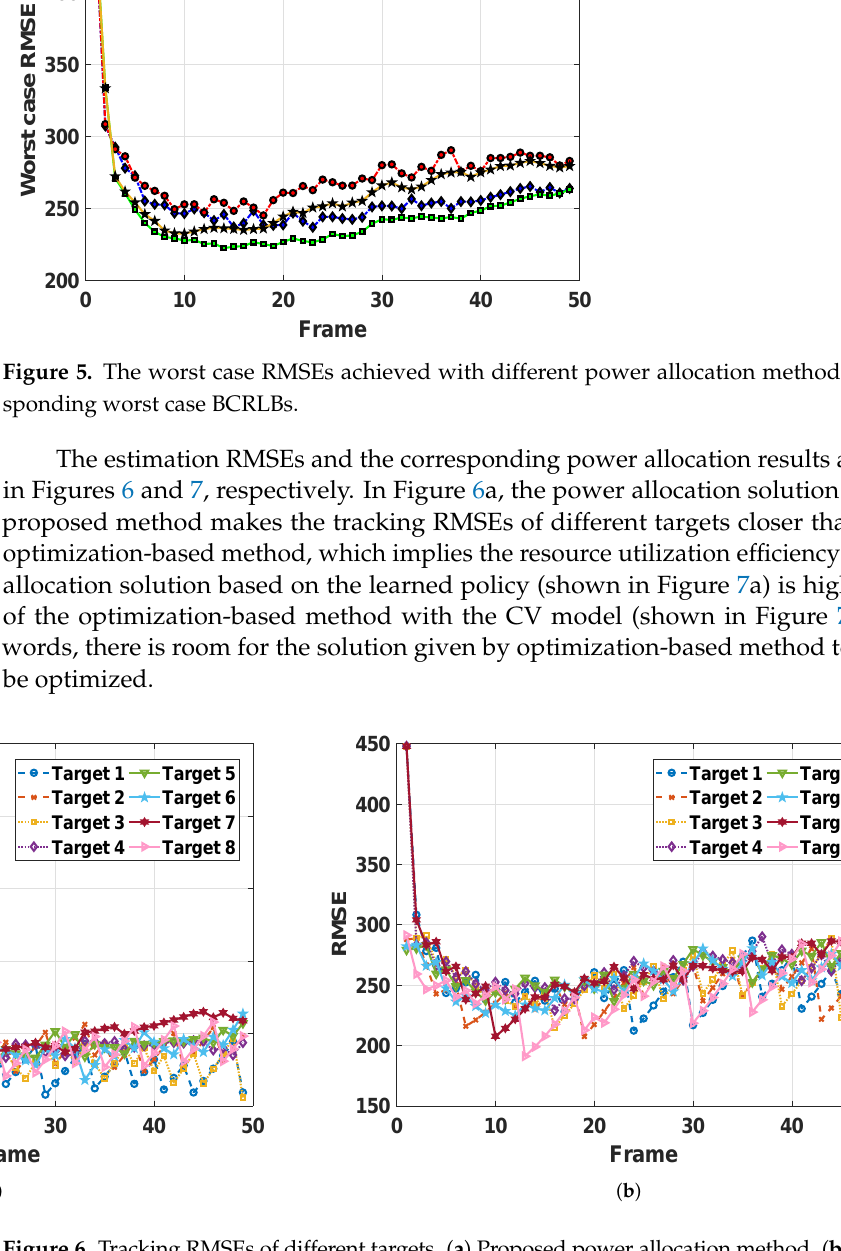
Figure 6. Tracking RMSEs of different targets. ( a ) Proposed power allocation method. ( b ) Optimization- based power allocation